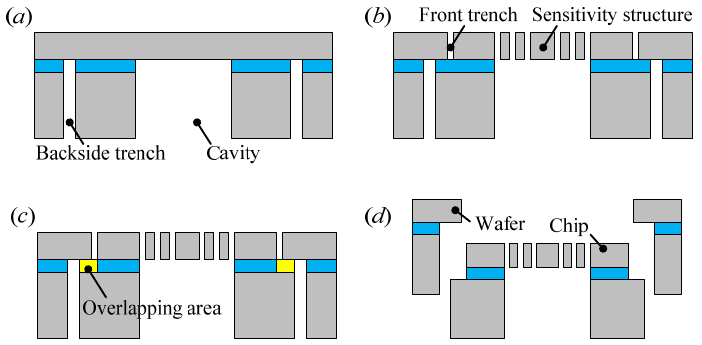
Figure 4. SOI-based dicing-free process. ( a ) Patterning of substrate layer. ( b ) Patterning of structure layer. ( c ) Etching of overlapping area. ( d ) Chip unloading.